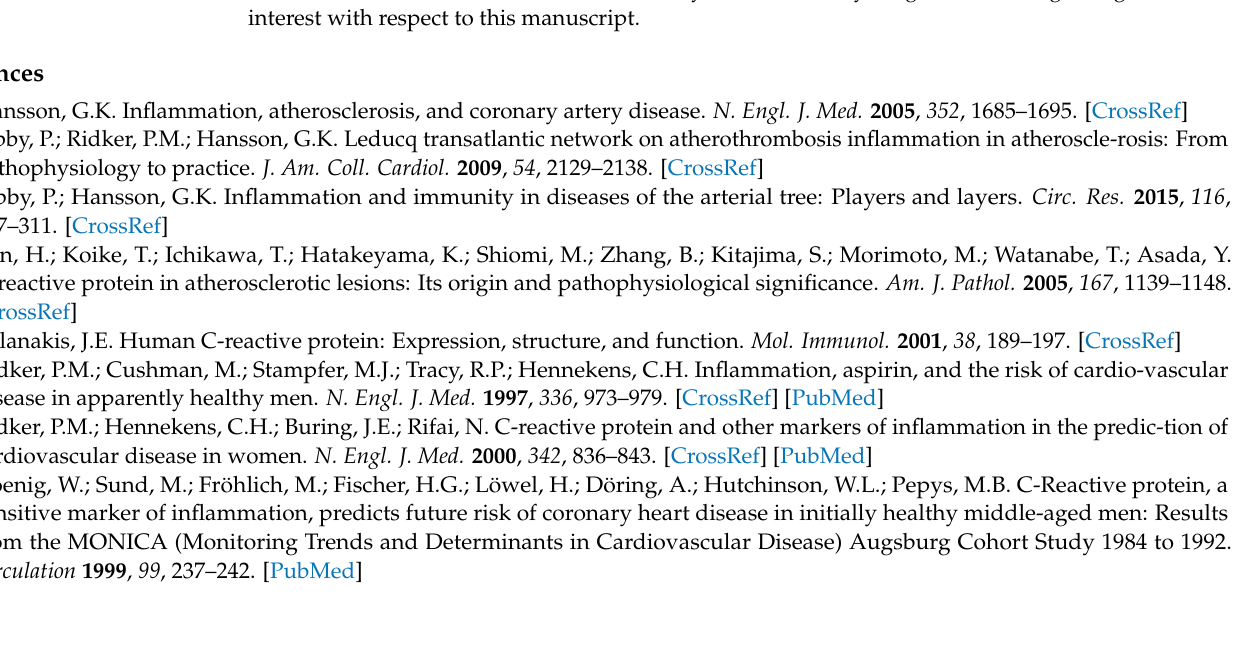
Table S2. Univariate Cox proportional hazards model in patients with Hs-CRP ≥ 2